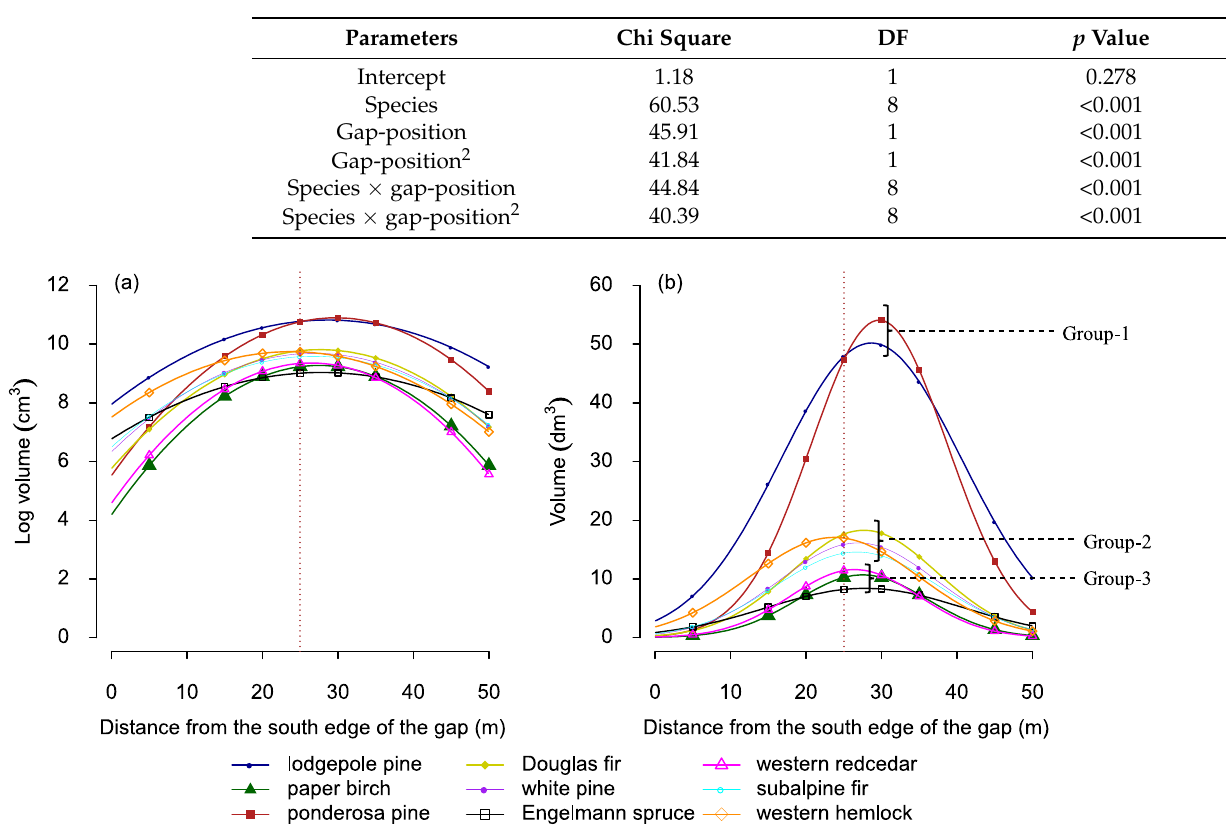
Figure 4. Fitted growth-gap-positions regression curves for log transformed volume ( a ) and original units ( b ). All fits are statistically significant ( p < 0.001). Panel b shows results after back transformation to original. Dashed brown line indicates the gap-center. Plots for individual species with their corresponding data points are shown in Figure A2.